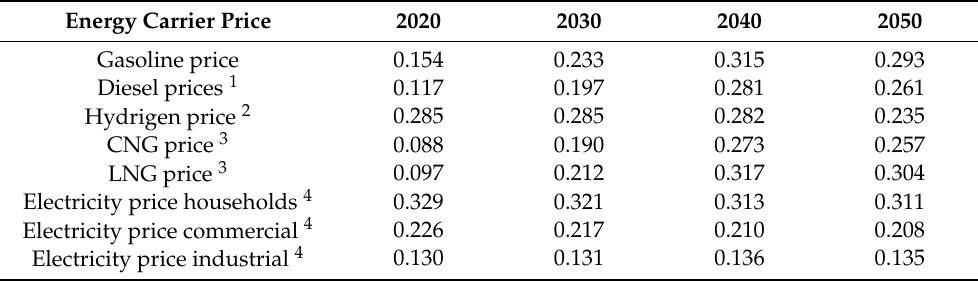
Table 4. Energy carrier prices ( € /kWh).